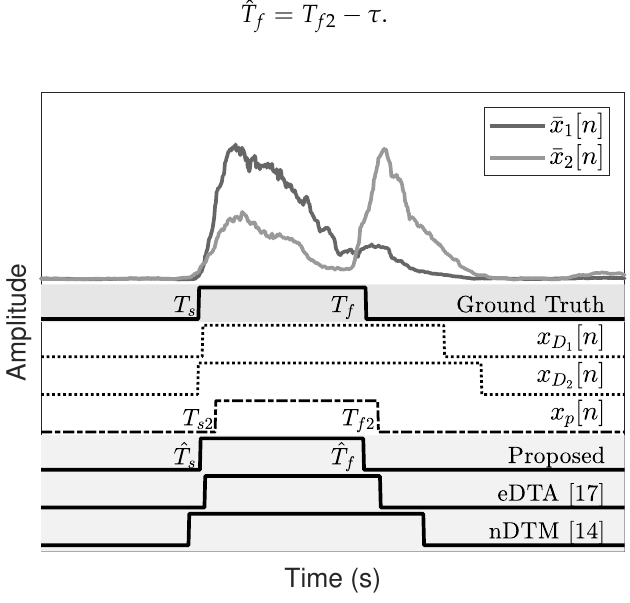
Figure 6. Estimated onset and offset results.